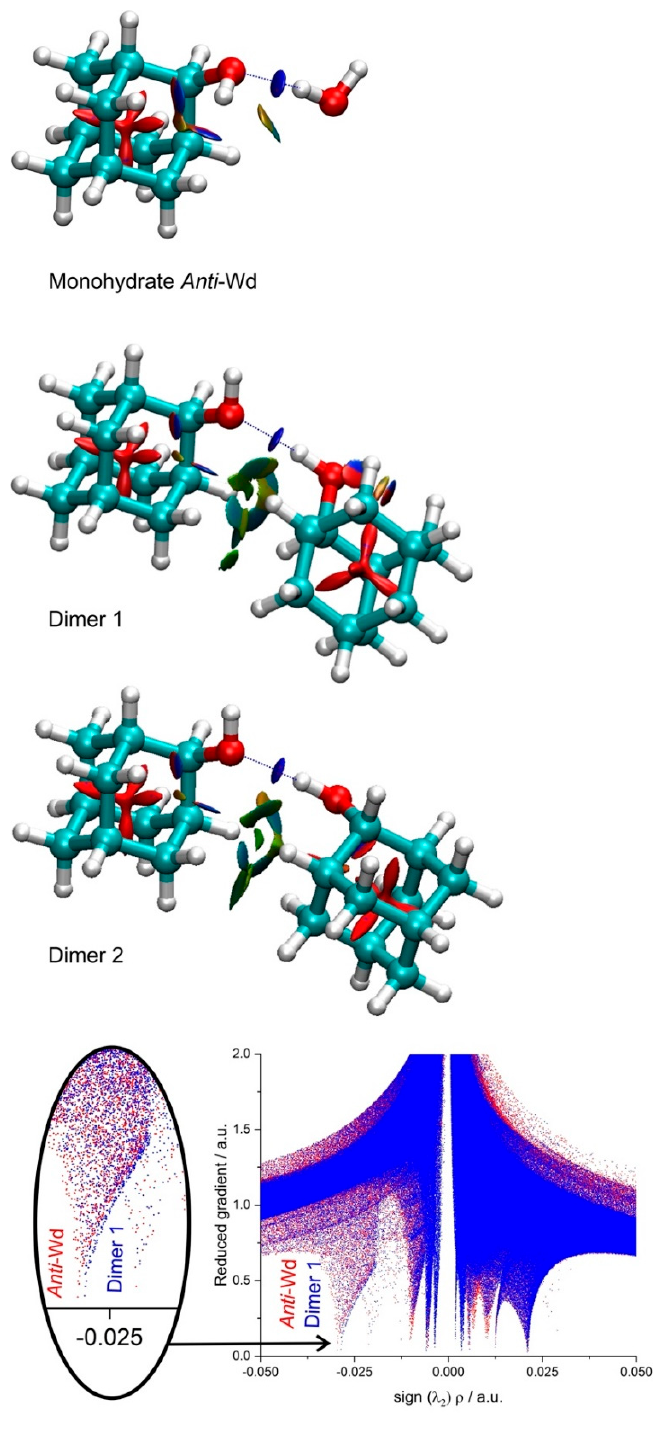
Figure 5. NCI plots [49] (upper panels) and reduced electronic density gradient (lowest panel) for the monohydrate and the two dimers of 2-adamantanol (isosurfaces with s = 0.5 a.u.). The NCI plot identifies attractive interactions (such as the O-H ··· O hydrogen bond) as blue shades, while green and red colors indicate, respectively, weak attractive interactions or repulsive interactions (such as ring critical points). The reduced electronic density of the lowest panel compares the attractive (negative minima) and repulsive (positive minima) interactions in the monohydrate (red dots) and isomer 1 (blue dots) of the 2-adamantanol dimer, dominated by the O-H ··· O interaction.